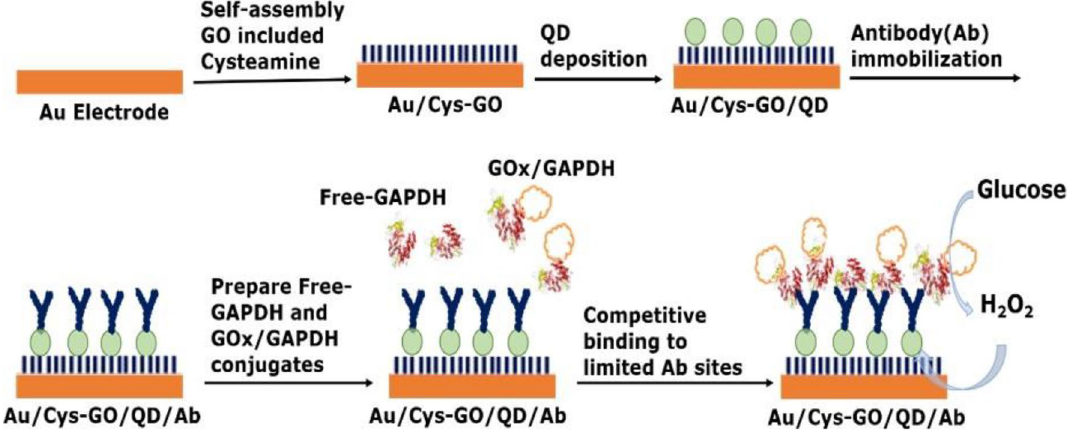
Figure 1. Schematic of GAPDH detection by using the QD-dissolution